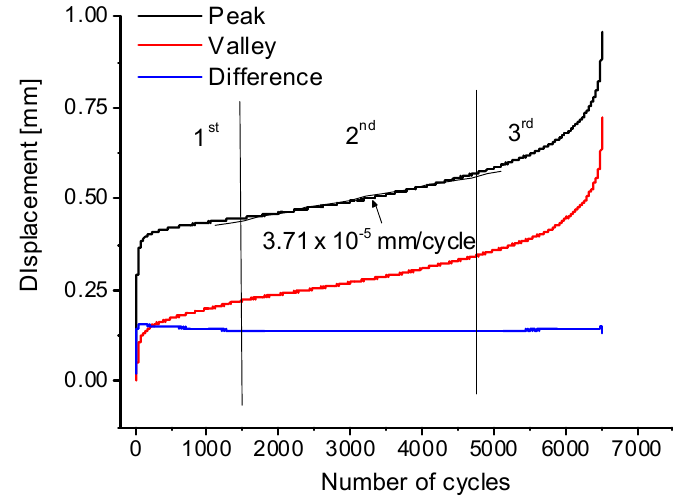
Figure 14. Evolutions of the peak and valley displacements, and of their difference (peak-to-valley) with respect to the number of cycles; the data correspond to specimen [111], with σ max / σ yield = 1.2.